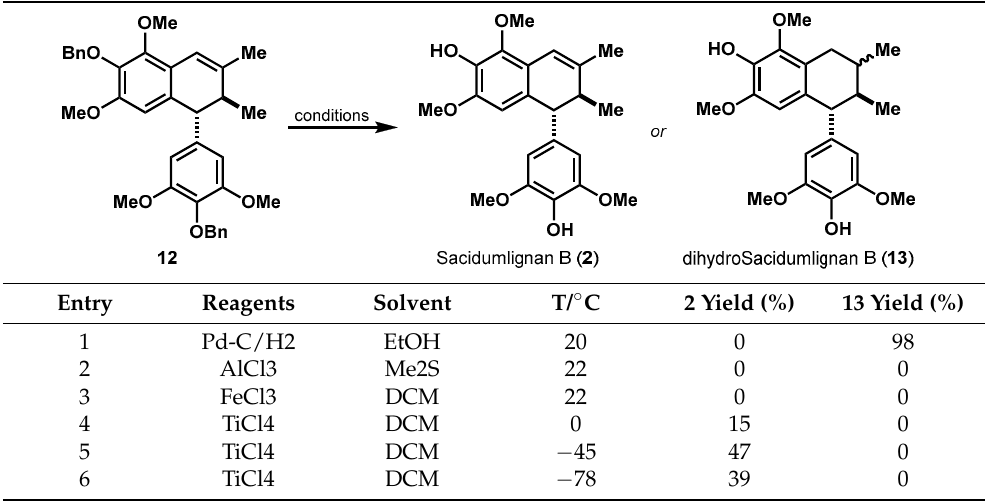
Table 1. Removal of Benzyl Groups.